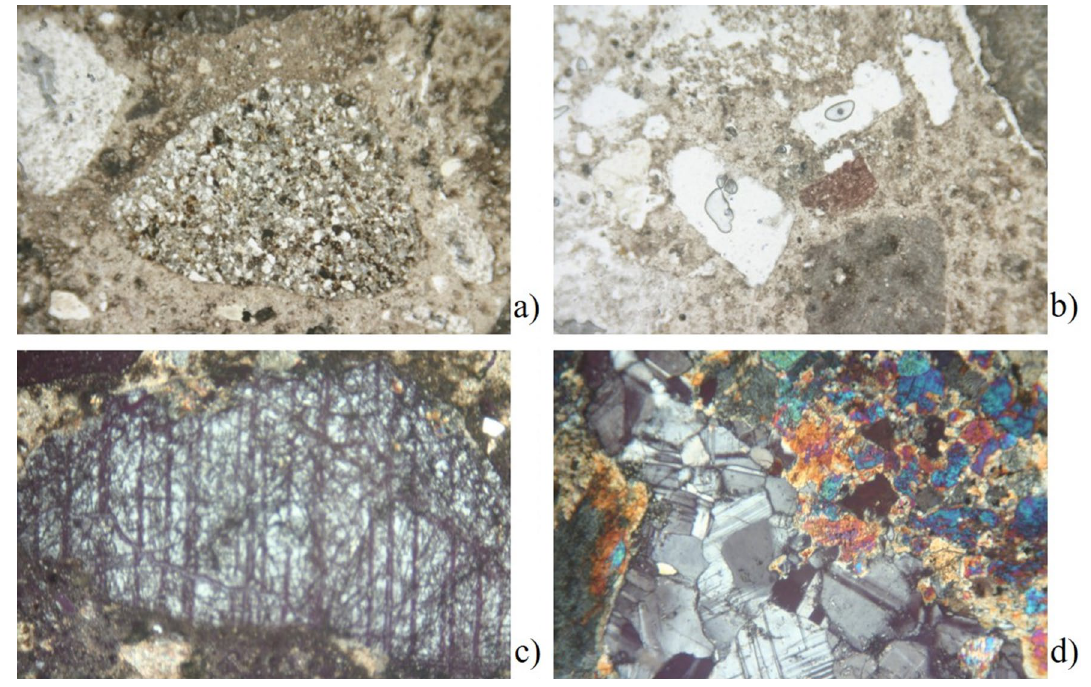
part; c ophycalcites observed at crossed nicols; d metamorphic minerals observed at crossed